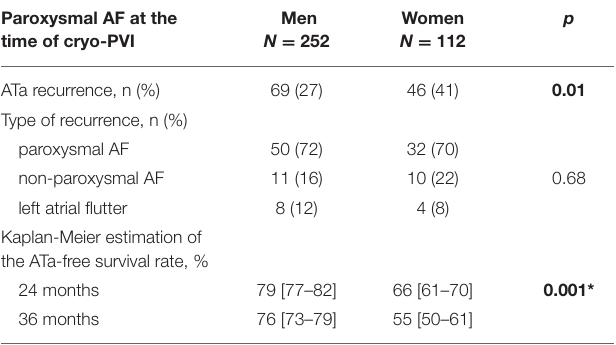
TABLE 4 | Predictive factors (multivariate analysis) of ATa recurrence after an index cryo-PVI for paroxysmal AF.